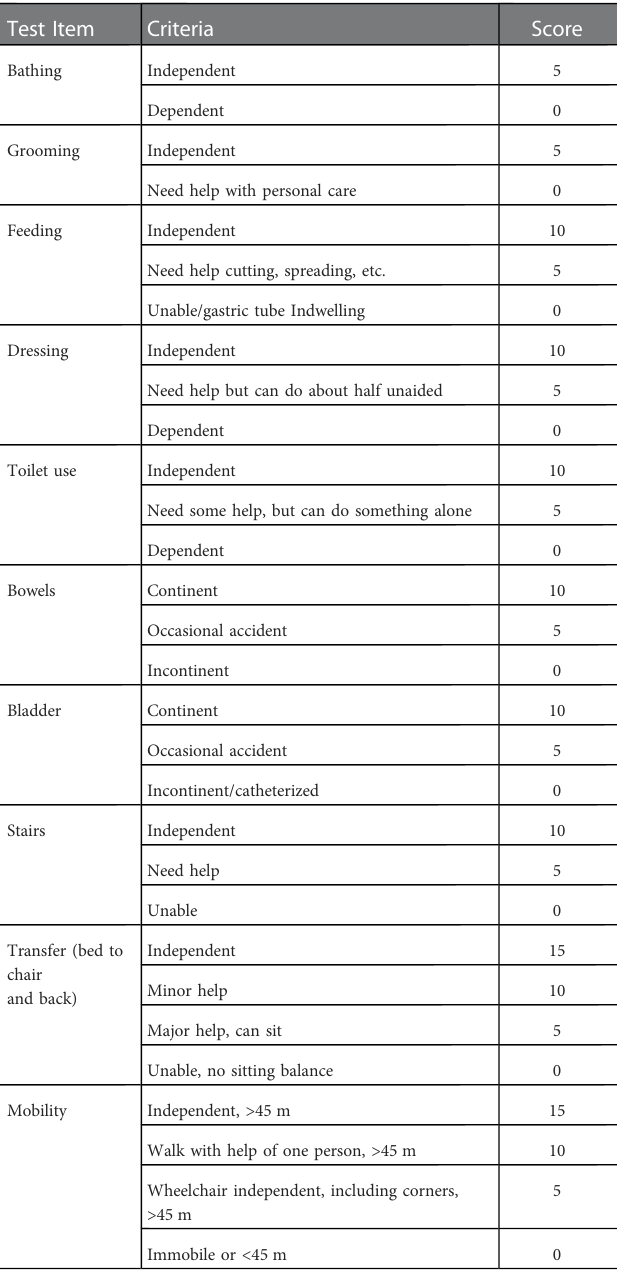
TABLE 3 Rating scale of Barthel Index of